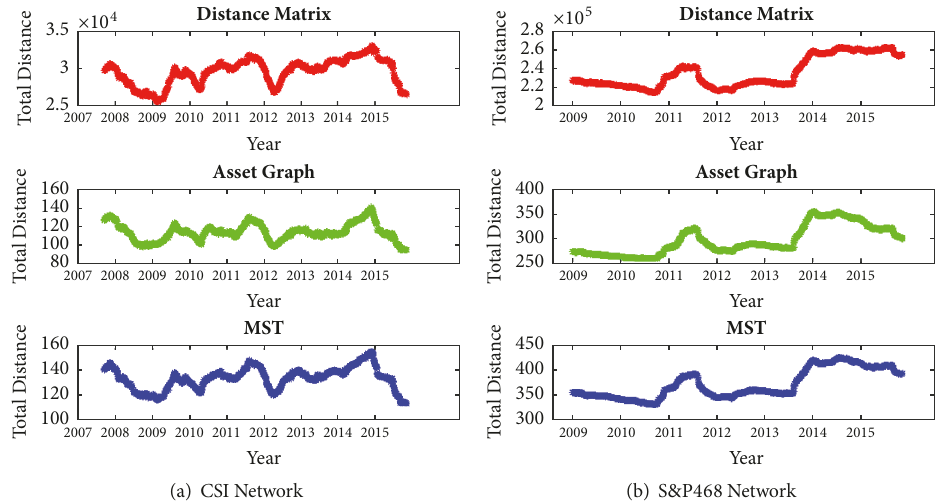
Figure 23: The evolving of total distances 𝑑 𝑡𝑜𝑡𝑎𝑙 of original network 𝑁 𝑡 , asset graph 𝐴𝐺 𝑡 , and minimum spanning tree 𝑀𝑆𝑇 𝑡 for CSI163 and S&P468 over time in the study period.